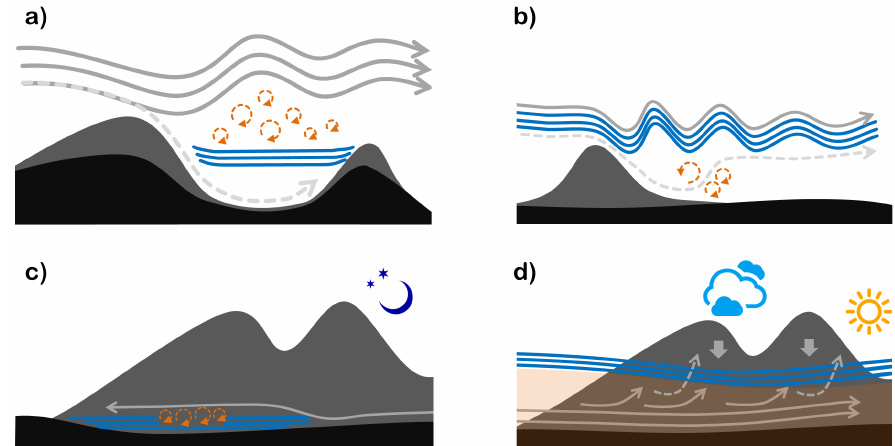
Figure 5. Role of stable layers (blue lines) in controlling multi-scale interactions. ( a ) Airflow over a valley, with (continuous grey lines) or without (dashed grey line) a stable layer below the mountain-top level, results, respectively, in elevated turbulence (orange whirls) and small-amplitude waves or in valley flushing and large-amplitude waves (adapted from [210]). ( b ) Airflow past an isolated mountain with (continous grey line) or without (dashed grey line) a low-level inversion above mountain-top level. In the former case, non-hydrostatic lee waves develop. In the latter, a large-amplitude hydrostatic wave forms, possibly conducive to boundary-layer separation and related turbulence (orange whirls). ( c ) Turbulent erosion of ground-based stable layers underneath a down-valley flow. ( d ) Confinement of moist air (orange shading) beneath a stable layer during daytime, possibly destabilizing the atmosphere. Thermally driven breezes advect air from the plain and upwards along the slopes (grey lines). Part of the upslope flow pierces the stable layer and causes mountain venting (dashed grey lines). Valley-core subsidence (down-pointing arrows) displaces the stable layer